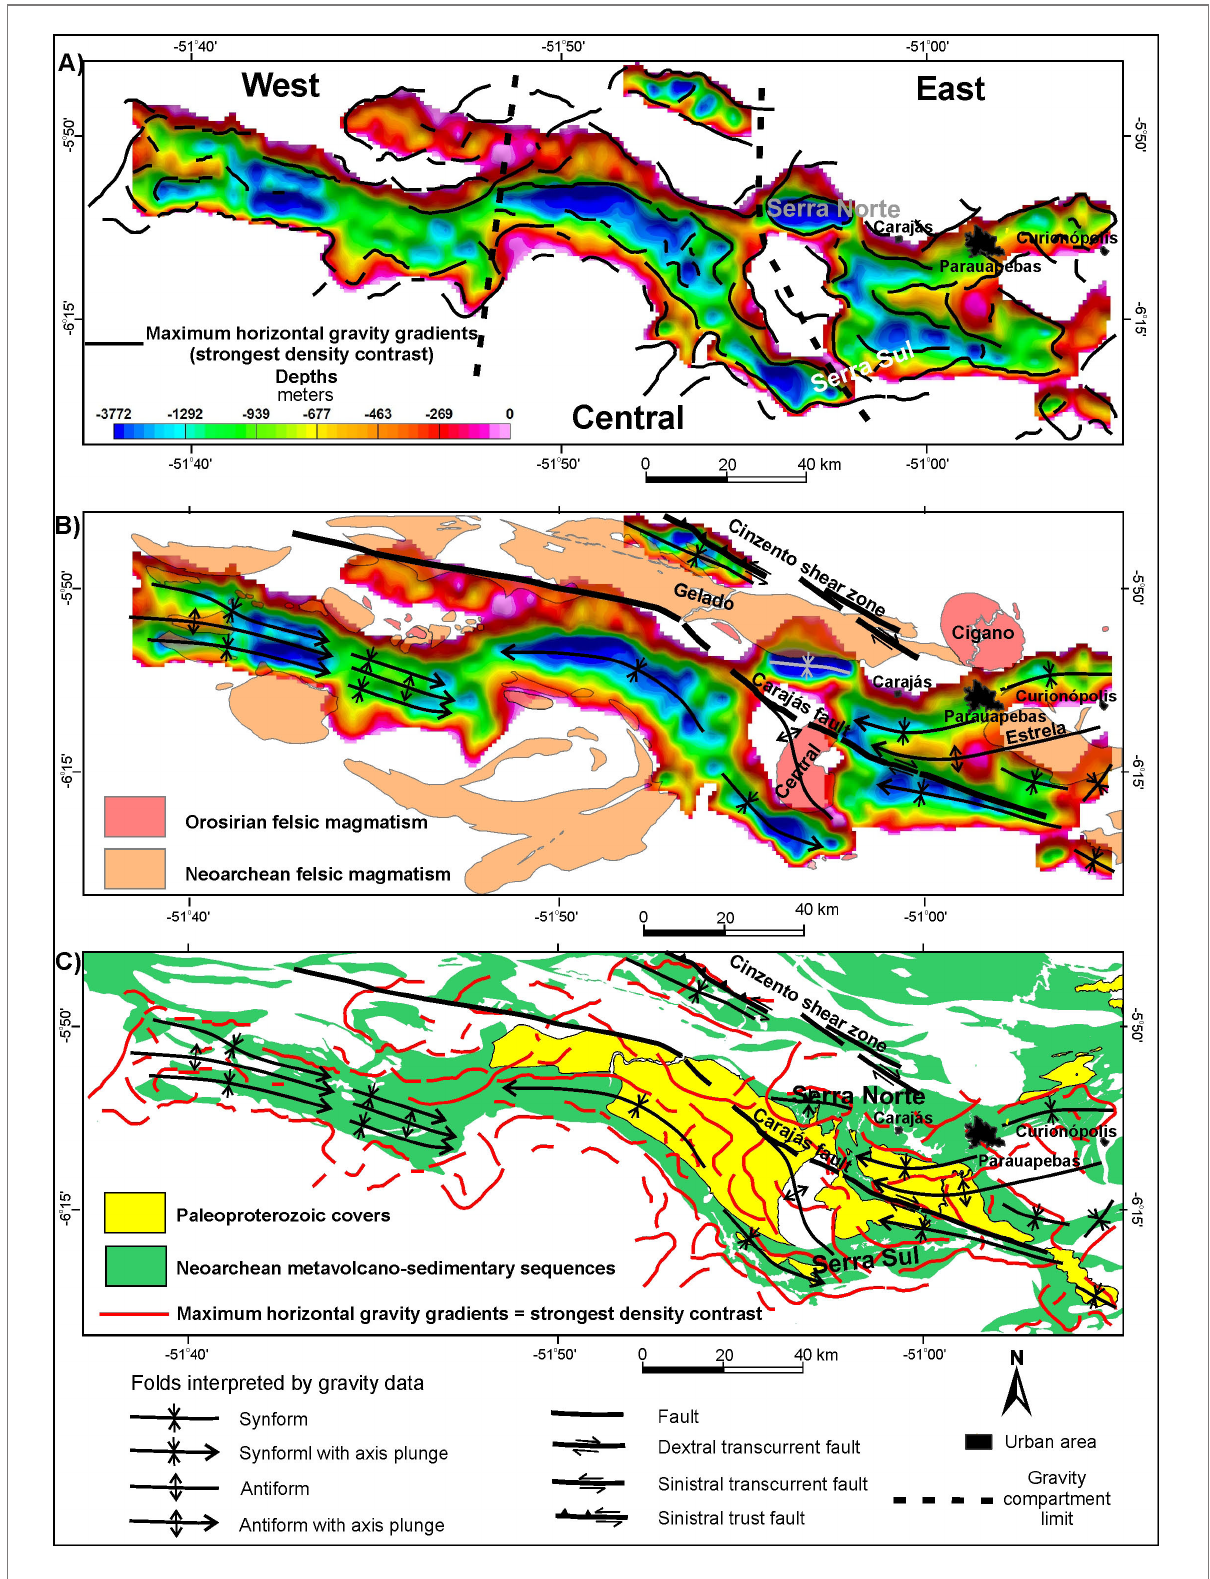
Figure 5 - A) Results of the forward modeling of the positive gravity anomalies correlated with metavolcano-sedimentary sequences of the Itacaíunas Supergroup with subdivision in three compartments and superposition of the maximum horizontal gradient (black lines); B) Results of the forward modeling of the positive gravity anomalies correlated with Neoarchean metavolcano-sedimentary sequences with interpreted axis of synformal and antiformal folds. The bodies of Neoarchean and Orosirian felsic magmatism are indicated; and C) Neoarchean metavolcano- sedimentary sequences and Paleoproterozoic covers with superposition of maximum horizontal gradient (red lines) and interpreted axis of synformal and antiformal